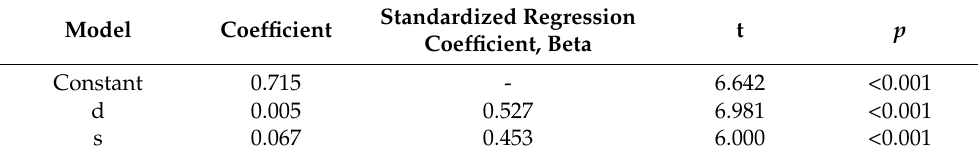
Table 13. Coefficients of the regression model for multi-asperity test.